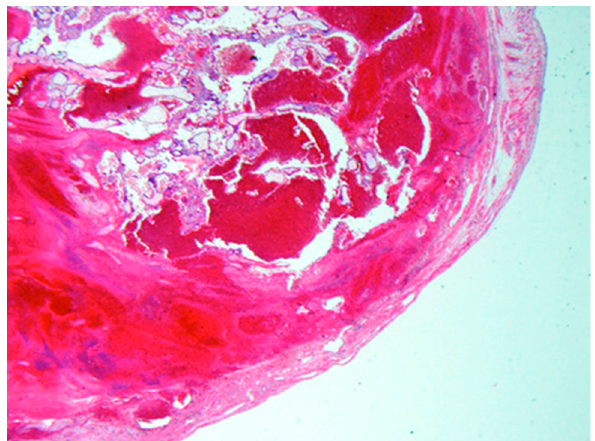
Figure 4. Histopathological examination of a persistent trophoblastic disease caused by insu ffi cient AE e ff ect on a patient with fallopian tube pregnancy (at 6 w 4 d; × 8). The fallopian tube was removed. Due to the e ff ect of AE, protein degeneration was observed in most tissues, although live villous cells were observed in